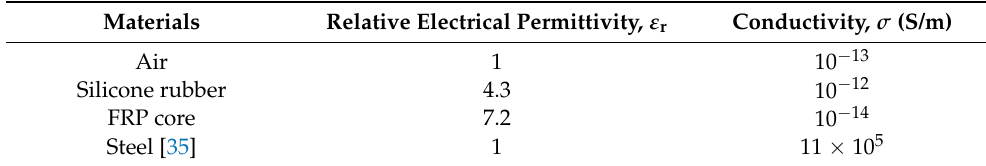
Figure 12. Modeled polymeric insulator structure. Table 4. Material properties of insulator model.